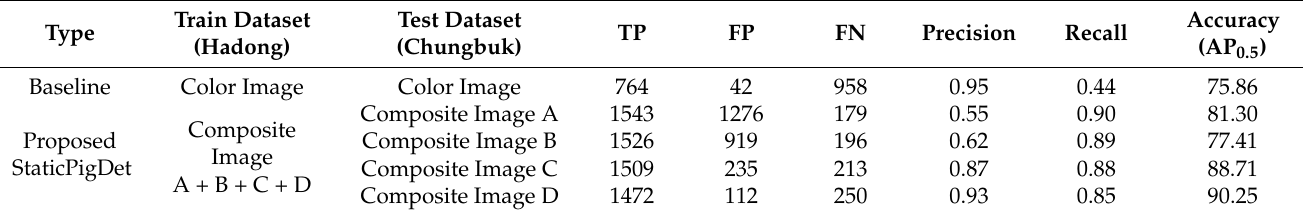
Table 6. Detection accuracy results for Chungbuk dataset with tinyYOLOv4 [41].